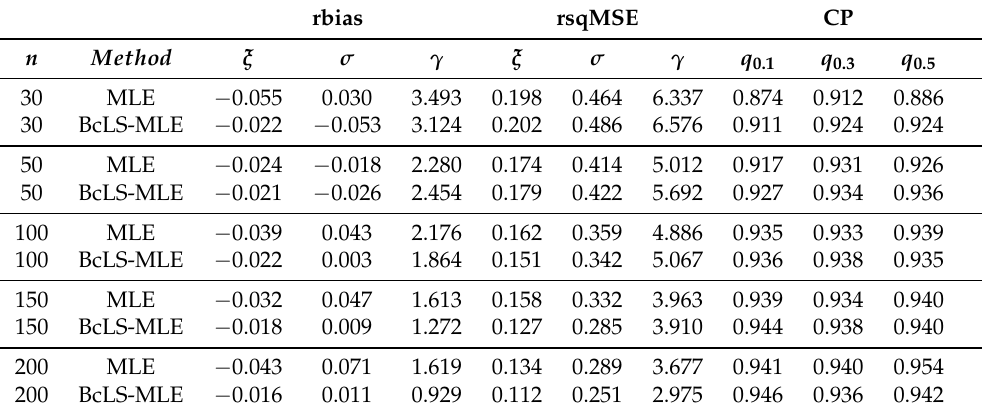
Table 3. The rbias and rsqMSEs of the BcLS-MLE and MLE, and the CP of S ( y 0 | Θ ) for LPN ( Θ ) with